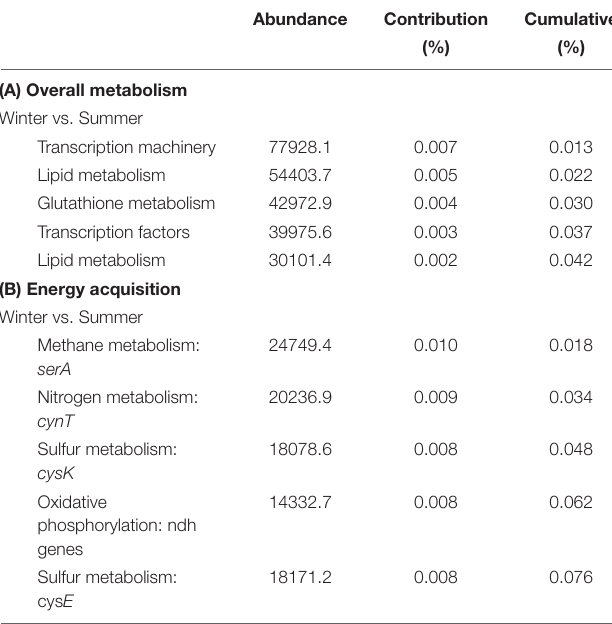
Abundance Contribution